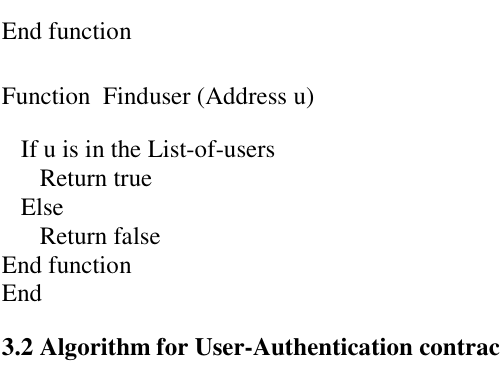
Algorithm 2: User-Authentication smart contract